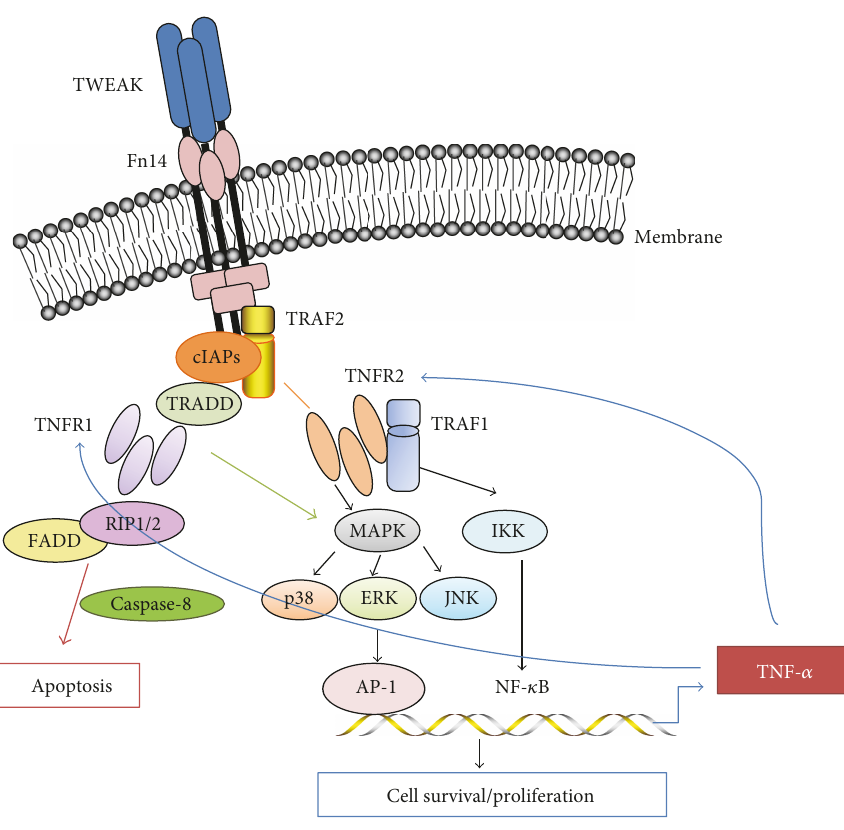
Figure 2: The diagram for the Fn14-TRAF-TNFR axis. sTWEAK binding to Fn14 recruits TRAF2 and cIAP1/2 to form cIAP-TRAF2 complex. The recruitment of TNFR1, TRADD, and FADD initiates apoptotic signaling by the recruitment and activation of caspase-8, while TNFR2 induces cell survival/antiapoptotic signals through NF- κ B activation. NF- κ B activation upregulates expression of multiple cellular genes that encode proin fl ammatory cytokines such as TNF- α . TWEAK may independently act or cooperate with TNF- α in regulating the TNFR-mediated cell